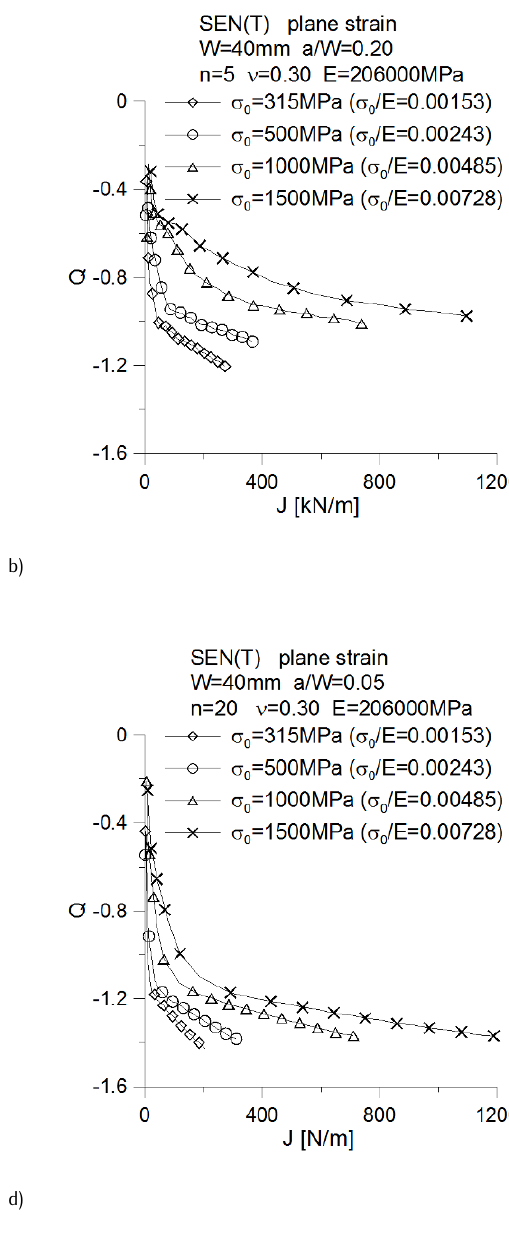
Figure 21. The influence of the yield stress on J - Q trajectories for SEN(T) specimens with crack length a / W =0.05 for different power exponents n in R-O relationship: a) n =3; b) n =5; c) n =10; d) n